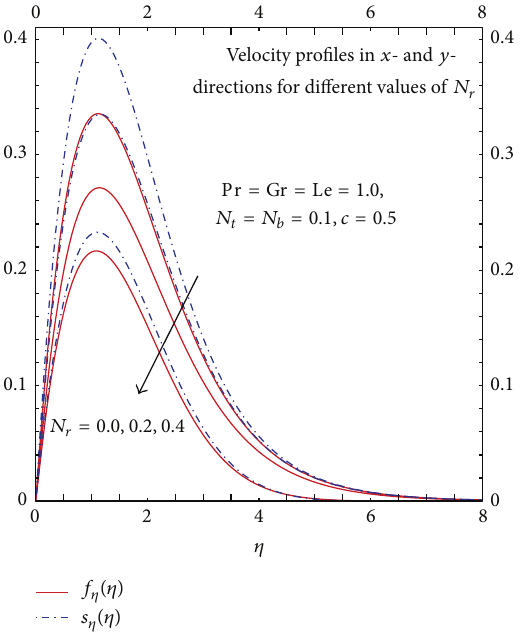
Figure 6: Graphs of 𝑓 𝜂 (𝜂) and 𝑠 𝜂 (𝜂) for different Le.